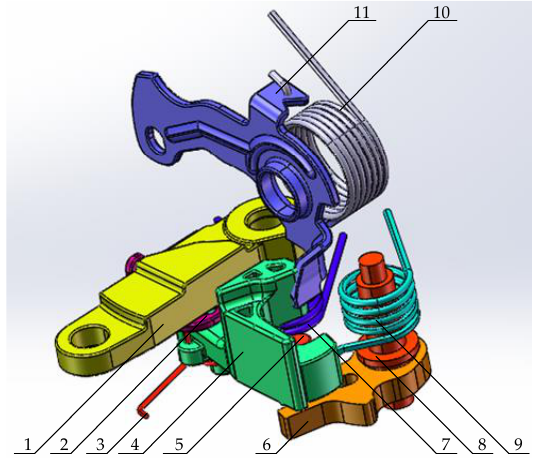
Figure 3. The inner and outer opening mechanism model. (1) Outside opening toggle arm, (2) opening connect arm, (3) lock return torsion spring, (4) pawl connect arm, (5) pawl connect shaft, (6) pawl, (7) opening connect arm torsion spring, (8) pawl riveting shaft, (9) pawl torsion spring, (10) inside opening toggle arm torsion spring, (11) inside opening toggle arm.